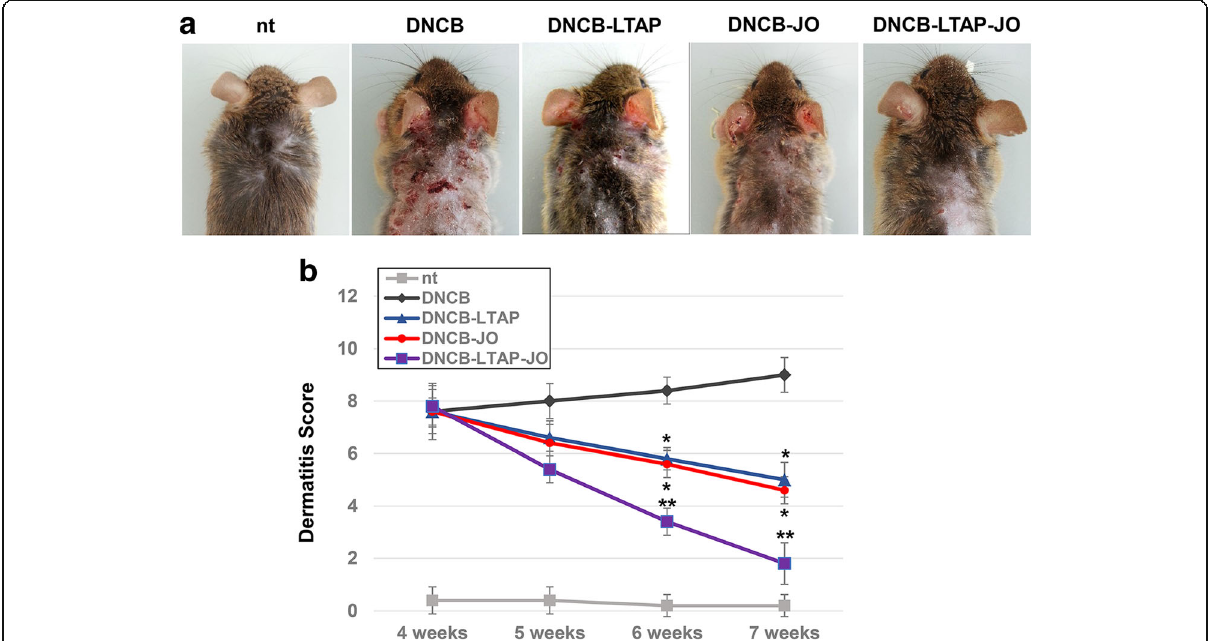
Fig. 2 The effects of LTAP-JO treatment on the clinical severity of DNCB-induced AD-like symptoms in mice. a Images of the dorsal lesions from the mice just after the sacrifice. b The dermatitis scores were evaluated weekly between the end of week 4 and week 7. Data represents the mean ± SEM ( n = 5). Means with the symbols (*, **) indicate significantly different from each other (against DNCB and DNCB-JO or DNCB-LTAP respectively) at p <